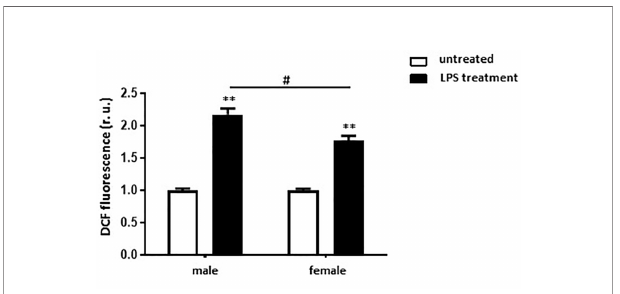
FIGURE 7 | LPS treatment leads to stronger ROS formation in male than in female BMMs. Analysis of ROS formation (DCF fl uorescence, r.u.) in untreated and M1 (10 ng/ml LPS for 24 h) male and female macrophages. Data are shown as means ± SEM (n = 6-7; independent experiments with technical